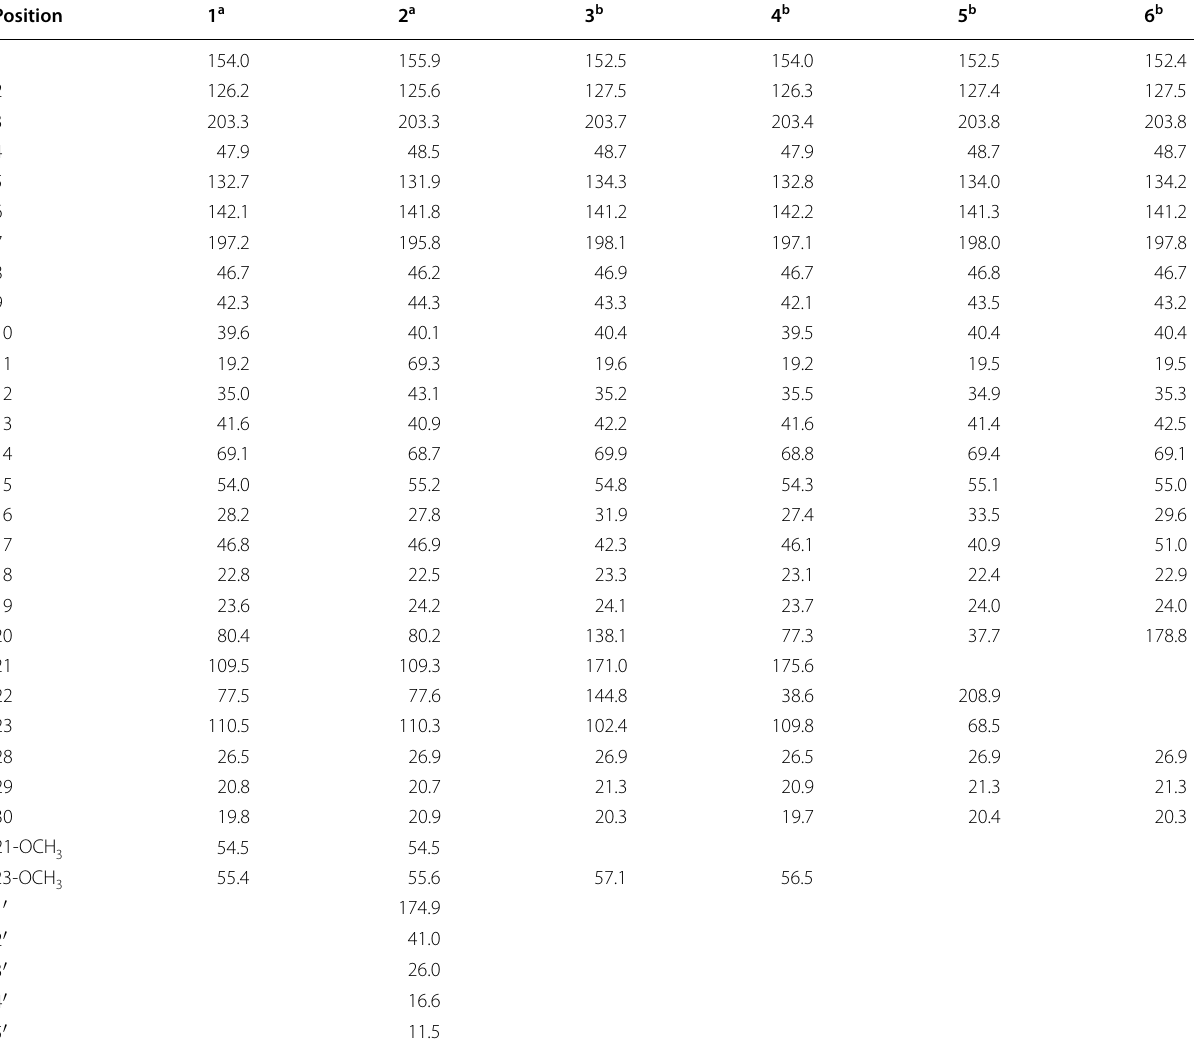
Table 2 13 C NMR spectroscopic data for 1 – 6